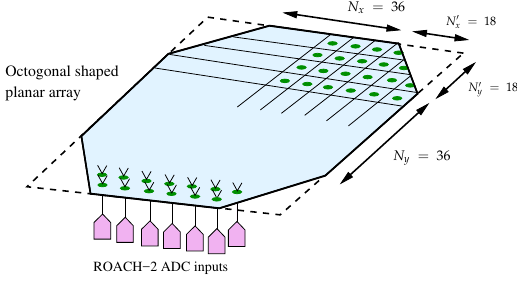
Figure 9. Proposed octogonal shaped 2D planar antenna array front end of the 3D radar.